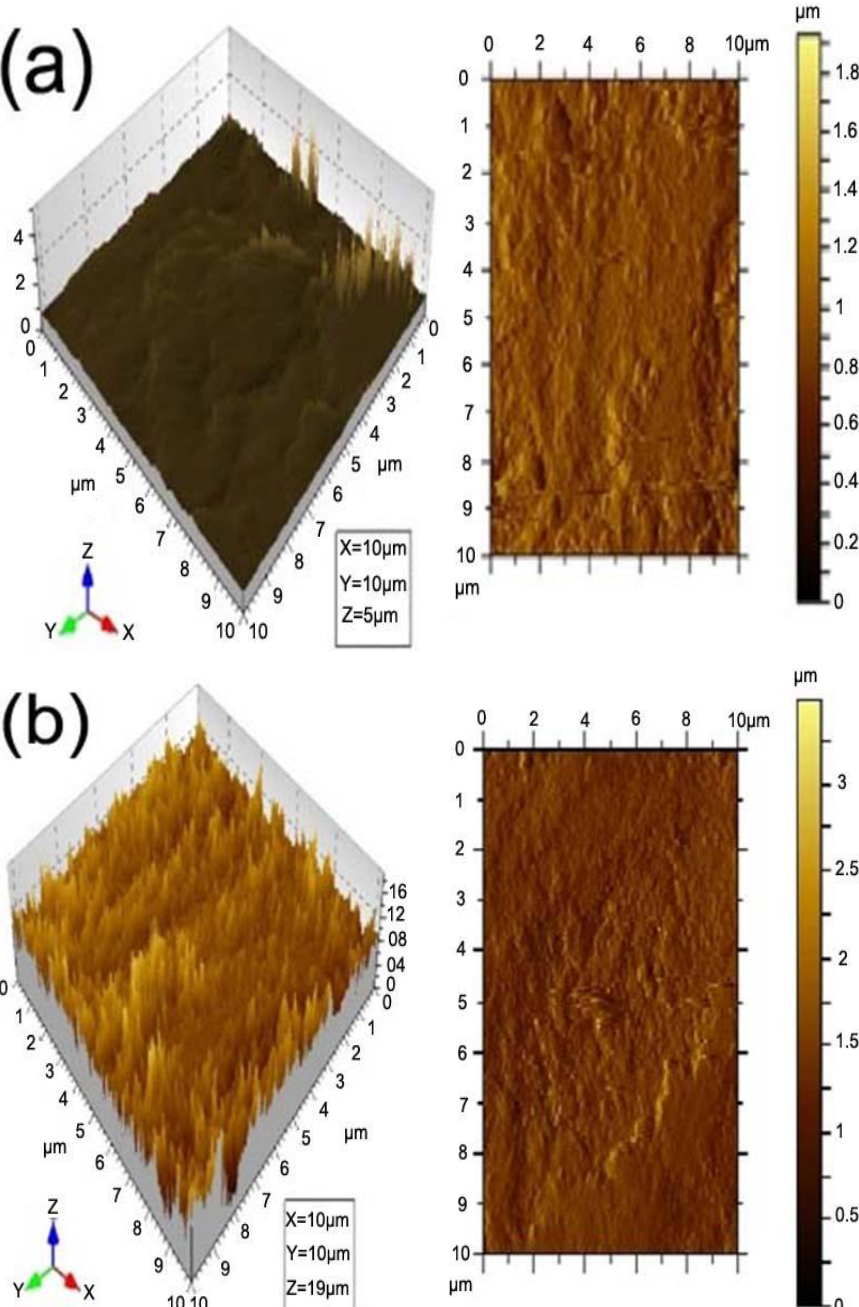
Figure 11. AFM micrographs of the eroded surface of the coated specimens at low and high water jet velocities. ( a ) Velocity: 10 m/s, angle: 60°, distance: 45 mm, erodent discharge: 1500 g/min; ( b ) velocity: 50 m/s, angle: 60°, distance: 45 mm, erodent discharge: 1500 g/min.